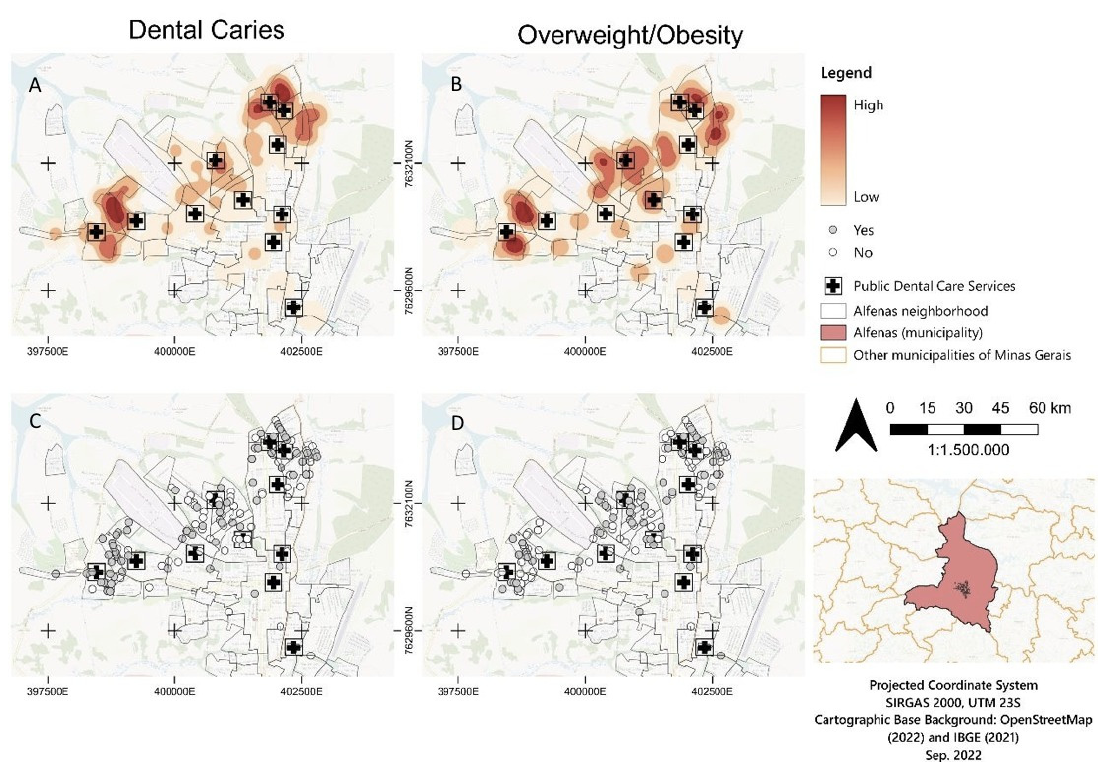
Figure 1. Maps representing the comparison of georeferencing of space distribution of residences of the children. ( A ) Cavitated dental caries represented by the heat map. ( B ) Overweight/obesity represented by the heat map. ( C ) Cavitated dental caries represented by the dots (each child is represented by a dot). ( D ) Overweight/obesity represented by the dots (each child is represented by a dot). The public dental care services are represented by the squares with the cross inside.